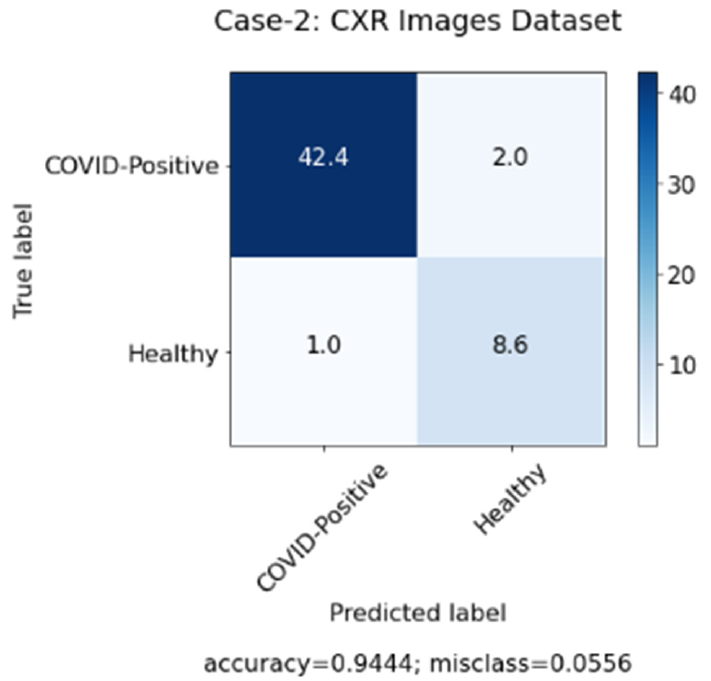
Figure 7. Confusion matrix for case 2 (chest X-ray (CXR)).